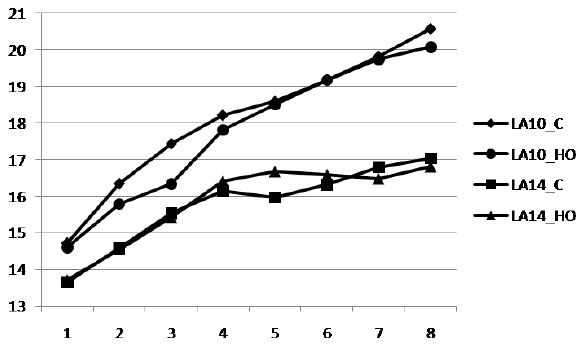
Figure 4. Changes in ultrasonic M. longissimus area as functions of feed in pigs of the Iberian breed.